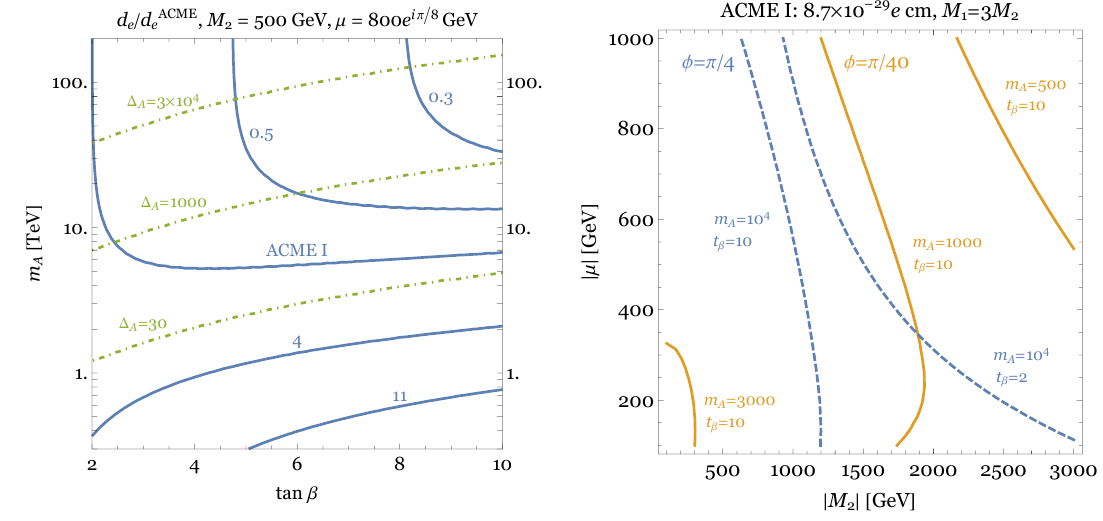
Figure 13 . E(cid:11)ect of including the full set of Higgs (cid:12)elds in two-loop chargino EDM contributions. Left: blue contours show the ratio of the electron EDM to the value 8 : 7 (cid:2) 10 (cid:0) 29 e cm marginally excluded by ACME. We have (cid:12)xed M 2 and (cid:22) to values for which the electron EDM saturates the current ACME constraint at tan (cid:12) = 2 and m A ! 1 . When m A is in the natural region, the electron EDM is signi(cid:12)cantly larger than when the heavy Higgses are decoupled. Green dotted lines indicate tree level tuning associated with the heavy Higgs (cid:12)elds. Right: here we show the current exclusion contours in the ( M 2 ; (cid:22) ) plane for several di(cid:11)erent choices of phase ( (cid:25)= 4 for blue dashed curves, (cid:25)= 40 for orange solid curves), m A (in GeV), and tan (cid:12) . Regions to the left and below the curves are